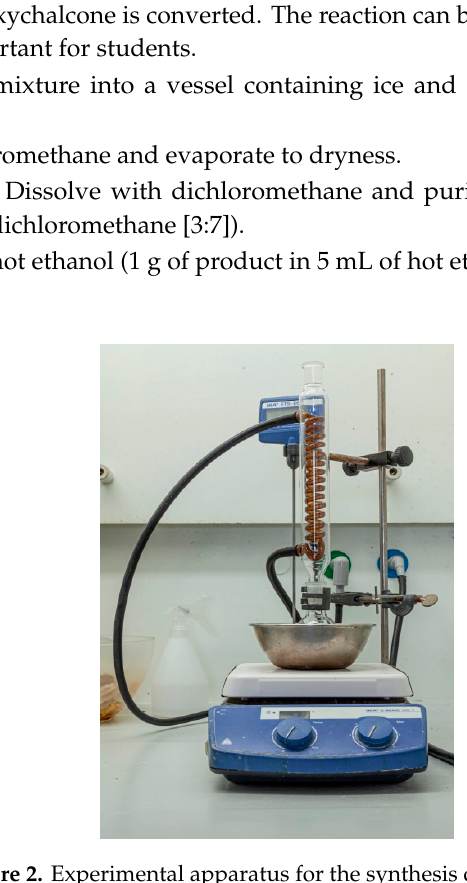
Figure 2. Experimental apparatus for the synthesis of flavanones.